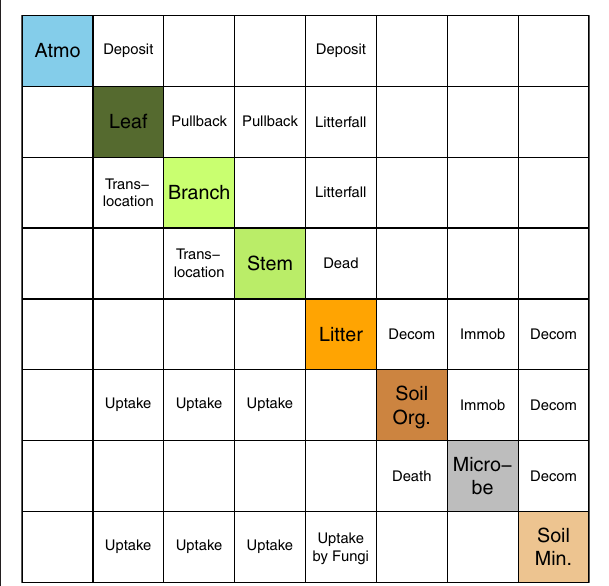
FIGURE 1 | Representation matrix of the FoRothCs model. Diagonal components (shaded) indicate variables in the model. The other components indicate processes that are explicitly included in the